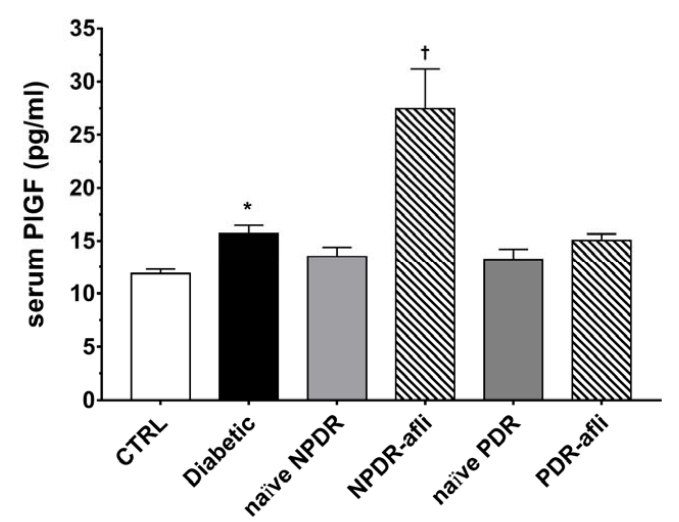
Figure 3. PlGF serum levels. After 7 days, aflibercept significantly ( p < 0.05) increased PlGF serum levels only in NPDR treated patients, compared to other study subject groups. * p < 0.05 vs. CTRL; † naïve vs. aflibercept treatment.